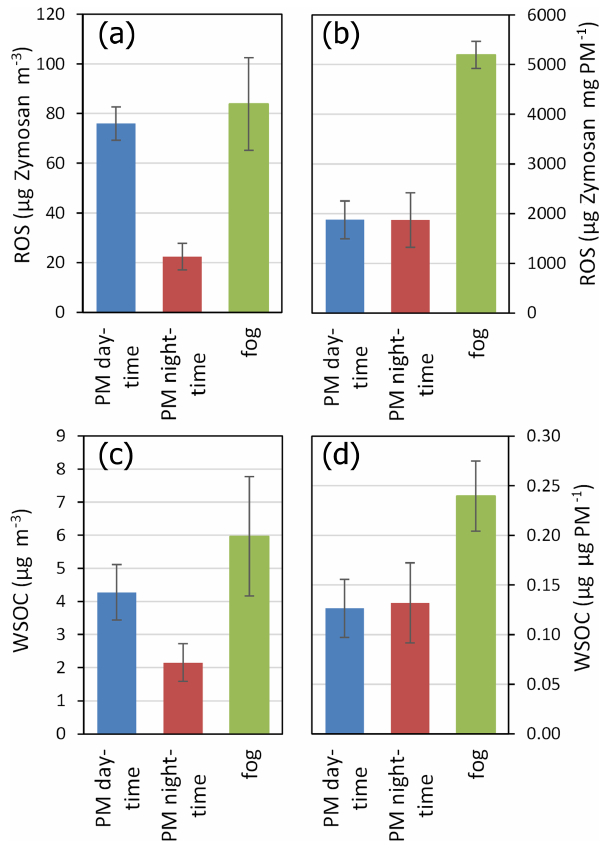
Figure 1. Per-volume (µgzymosanm − 3 air) (a) and per-mass (µgzymosanmgPM) (b) ROS activity of the fog water and aerosol samples collected in the Po Valley in fall 2015. The results pertain to parallel aerosol and fog samples. The values for aerosol samples are based on the unfiltered ROS analysis protocol. Bars represent geo- metric means and error bars correspond to 1 standard error (SD). Lower panels (c, d) are the same as (a) and (b) , but for WSOC.